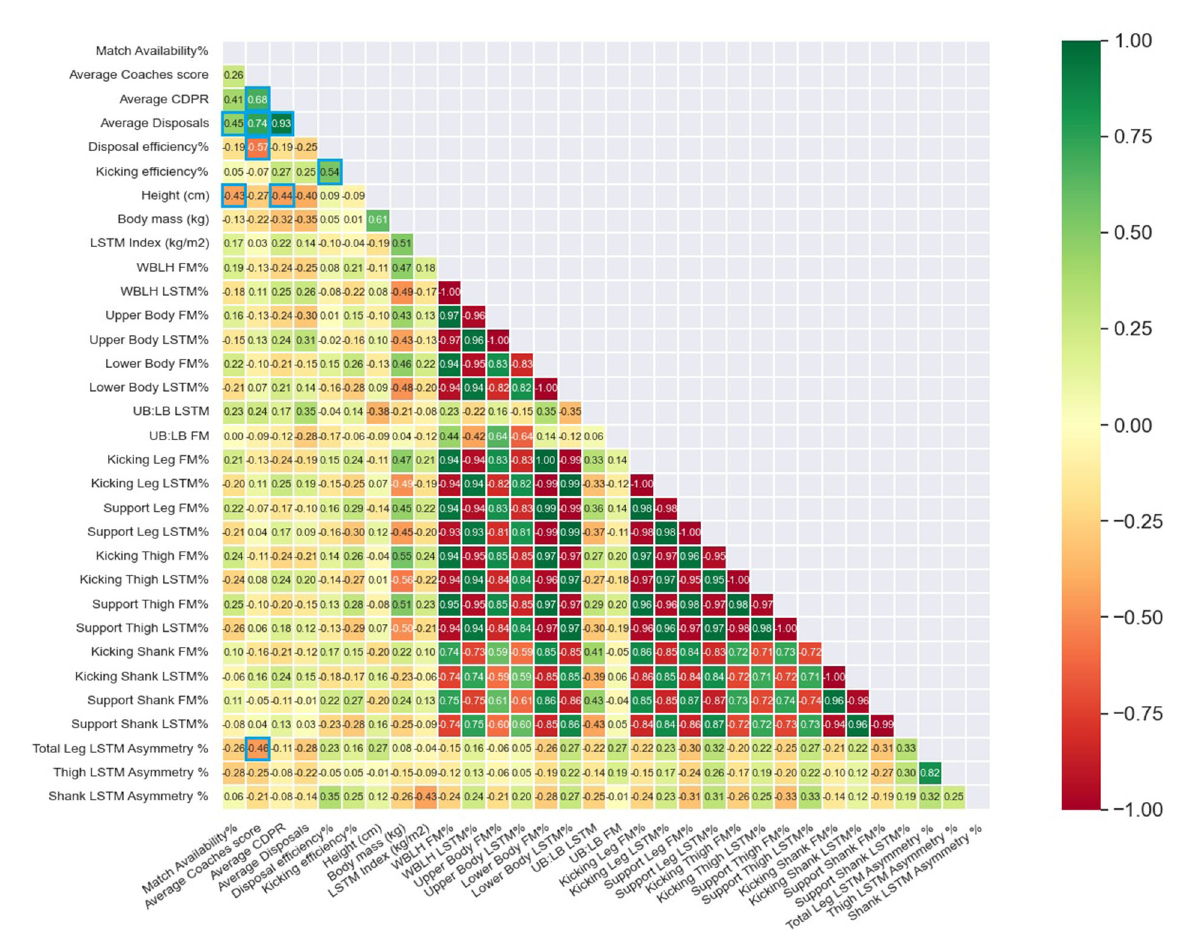
FIGURE1 Pearson correlation matrix examining the association between pre-season body composition characteristics expressed as relative values, and in-season match availability and match performance. Significant ( p ≤ 0.05) relationships are represented by blue boxes. CDPR, Champion Data Player Rank; LSTM, Lean soft-tissue mass; UB, Upper body; LB, Lower body; FM, fat